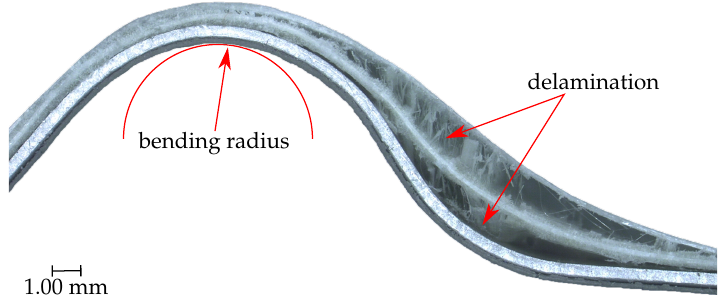
Figure 7. Failure of the thermoplastic laminate after the static three-point bending test.